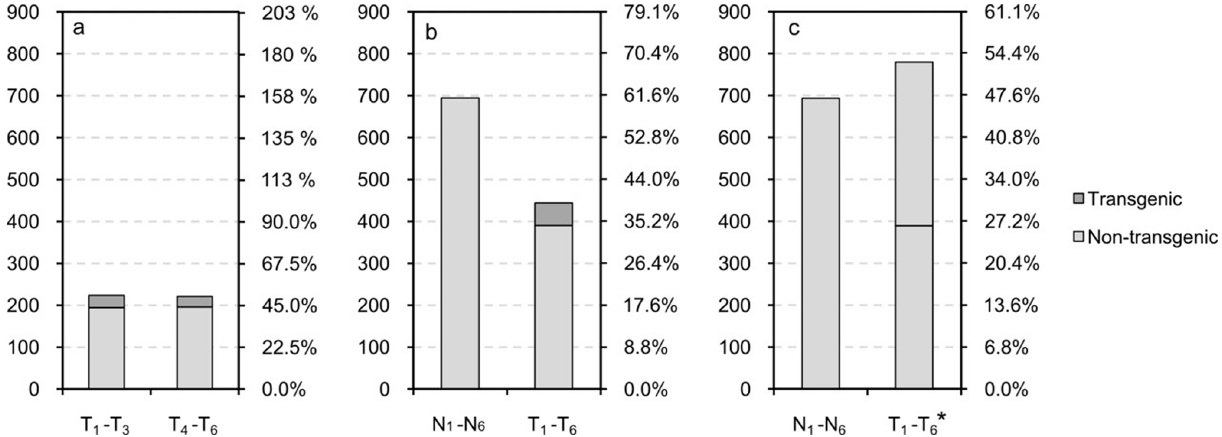
Figure 2. Number and ratio of each offspring population and the significance test between offspring populations. a: T1–T3 are the numbers of offspring of small transgenic males, T4–T6 are the numbers of offspring of large transgenic males; b: N1–N6 are the numbers of offspring of wild-type males, T1–T6 are the numbers of offspring of transgenic males; c: N1–N6 are the numbers of offspring of wild-type males, T1–T6* are the numbers of offspring of transgenic males after correction. Left vertical axis shows the number of individuals; right vertical axis shows the ratio of offspring populations. doi:10.1371/journal.pone.0065506.g002 PLOS ONE |